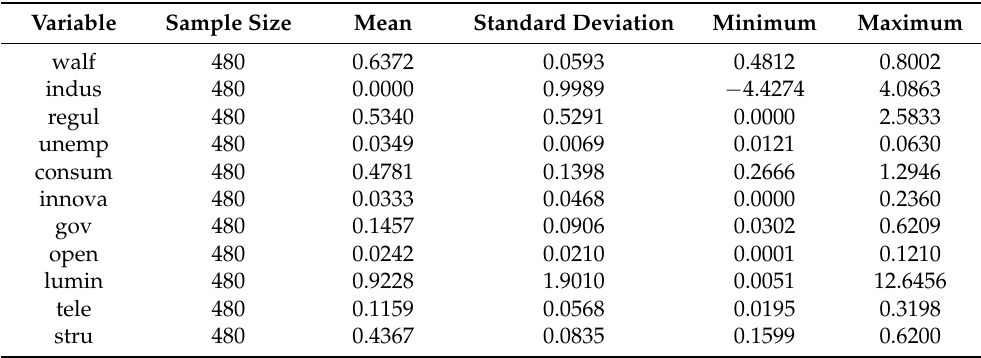
Table 1. Descriptive statistics of the main